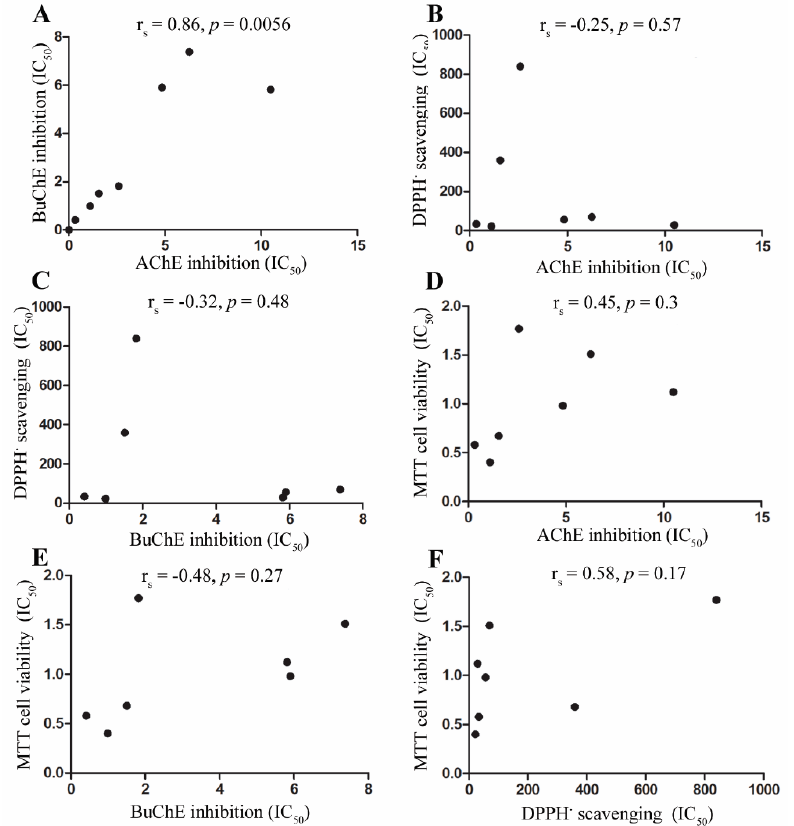
Figure 6. Correlation analysis between anti-cholinesterase activities, DPPH radical scavenging, and cell viability for plant extracts. (a) Correlation between BuChE and AChE potency. ( b ) Correlation viability for plant extracts. ( A ) Correlation between BuChE and AChE potency. ( B ) Correlation between between DPPH radical scavenging and AChE inhibition. ( c ) Correlation between DPPH radical DPPH radical scavenging and AChE inhibition. ( C ) Correlation between DPPH radical scavenging and scavenging and BuChE inhibition. ( d ) Correlation between cell viability and AChE inhibition. ( e ) BuChE inhibition. ( D ) Correlation between cell viability and AChE inhibition. ( E ) Correlation between Correlation between cell viability and BuChE inhibition. ( f ) Correlation between cell viability and cell viability and BuChE inhibition. ( F ) Correlation between cell viability and DPPH radical DPPH radical scavenging.